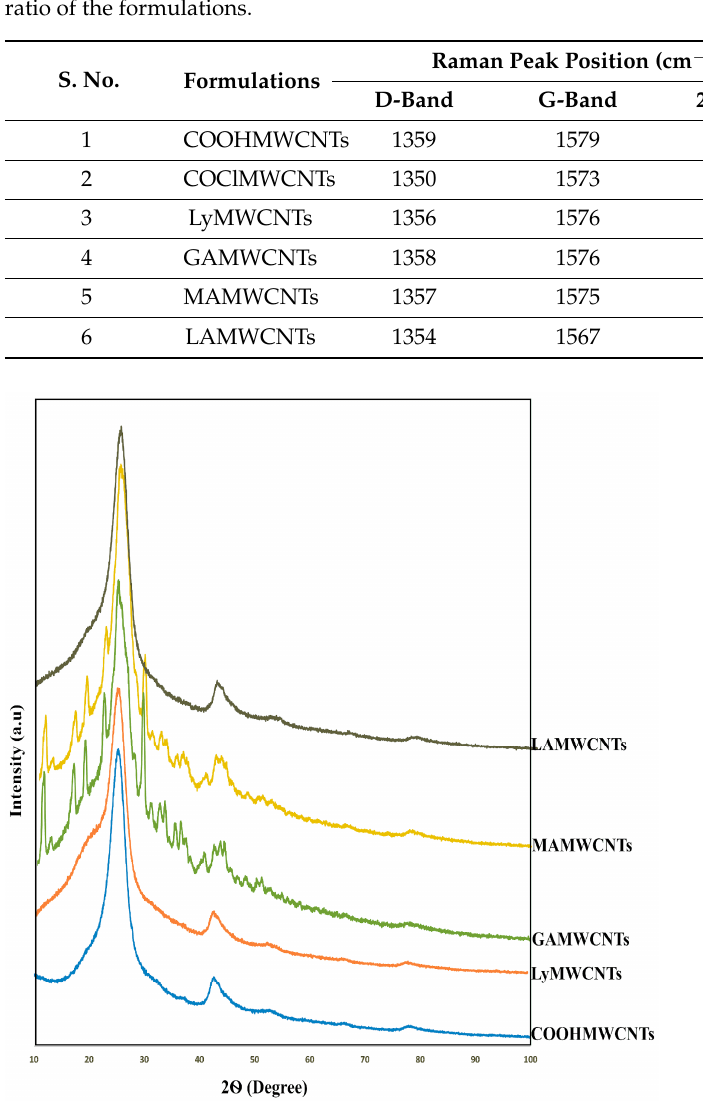
Figure 6. XRD pattern of the functionalized carboxylated